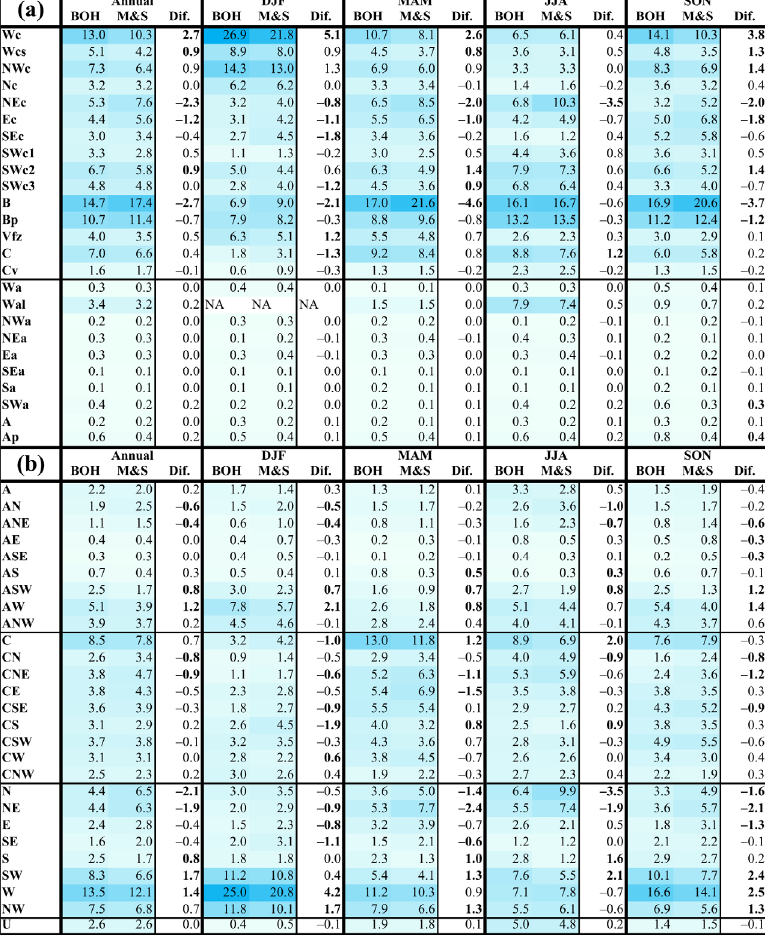
Figure 6. Relative annual and seasonal (DJF: December–February; MAM: March–May; JJA: June– August; and SON: September–November) proportions (%) of the individual circulation types under the CHMI ( a ) and objective ( b ) classifications in the overall precipitation totals in Bohemia (BOH) and Moravia and Silesia (M&S) and differences (Dif) during the 1961–2020 period. Statistically significant differences at the 0.05 significance level are denoted in bold type. The values are highlighted by the color scale of blue shades.